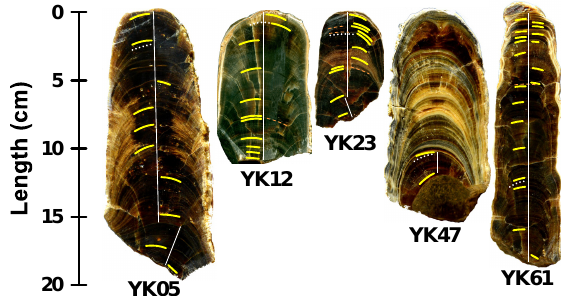
Figure 2. Photographs of the five stalagmites collected from Yangkou cave. Brown dashed curves show hiatuses. Straight lines represent subsampling routes for oxygen isotope measurement. Yel- low curves denote drilled subsamples for U-Th dating. White dots are the subsamples collected for Hendy test (Hendy,